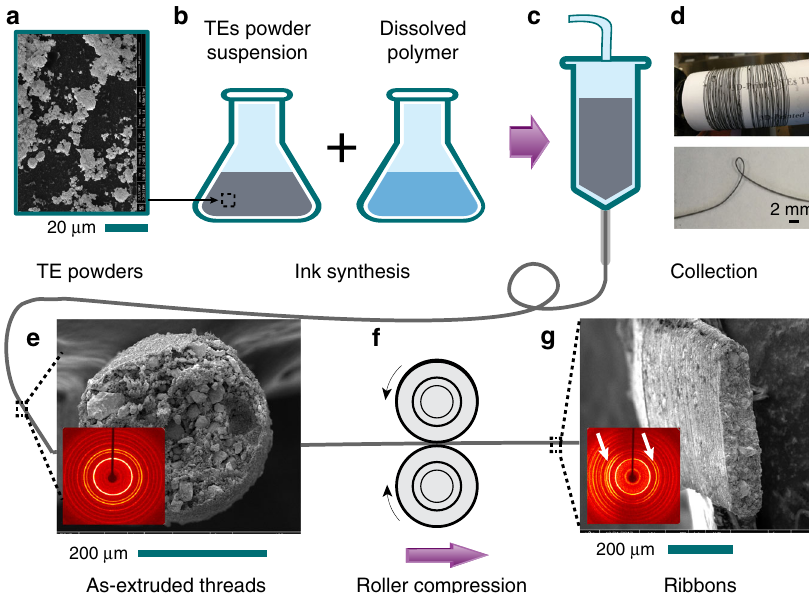
Fig. 1 Schematic diagrams of continuous thermoelectric threads production. a Both p - and n -type Bi 2 Te 3 powders, size <20 µ m, are dispersed in the b polymer solution to form composite paints, respectively. c 3D-paints with proper viscosity are extruded out through a needle at room temperature, and d continuous threads with a diameter of 250 ± 40 µ m are collected on a cardboard roller with a collection speed of 4 cm/s. The bending radius of as- extruded threads was less than 2 mm. e The cross-section surface morphology of extruded circular threads with fi ll volume fraction Φ (0) = 54 vol% reveals an X-ray diffraction pattern (inset) for random dispersed powders described by the Herman ’ s orientation parameter f = 0%; in comparison, f through the paired rollers, g the compressed ribbon with volume fraction Φ ( p max ) = 65 vol% reveals a diffraction pattern (inset) indicating oriented powders along thread direction with f = 30%. The white arrows point out the arcs used for orientation measurements.